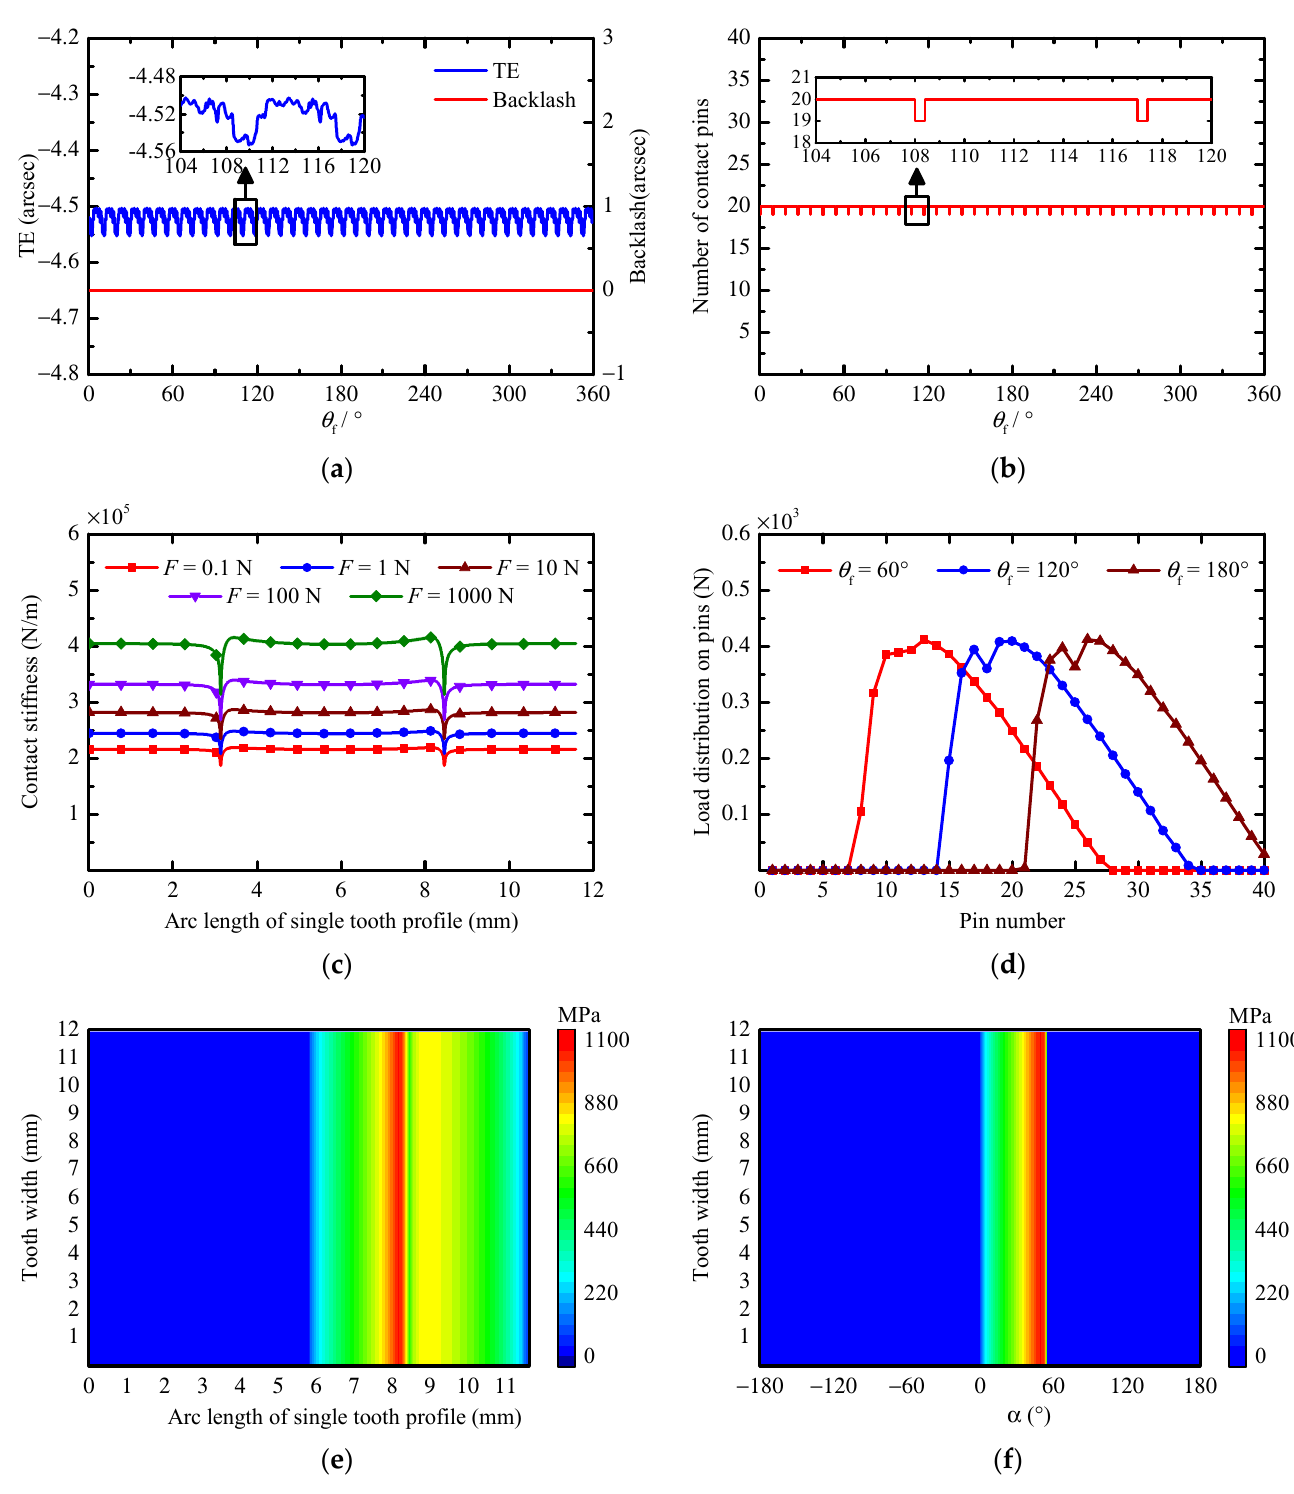
Figure 7. The results for the perfect tooth surface: ( a ) TE and backlash, ( b ) number of contact pins, ( c ) relationship between contact stiffness and contact force at different arc length positions, ( d ) load distribution on pins, ( e ) contact stress on the tooth surface of the cycloid gear, and ( f ) contact stress on the tooth surface of the